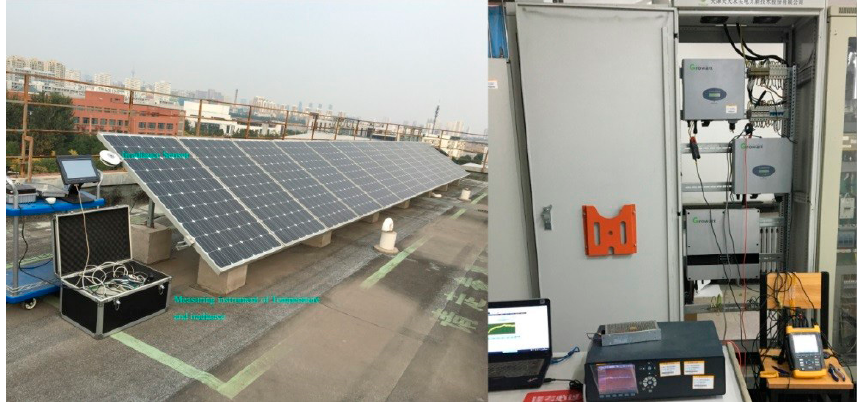
Figure 6. PV system and environmental parameters measurement system.